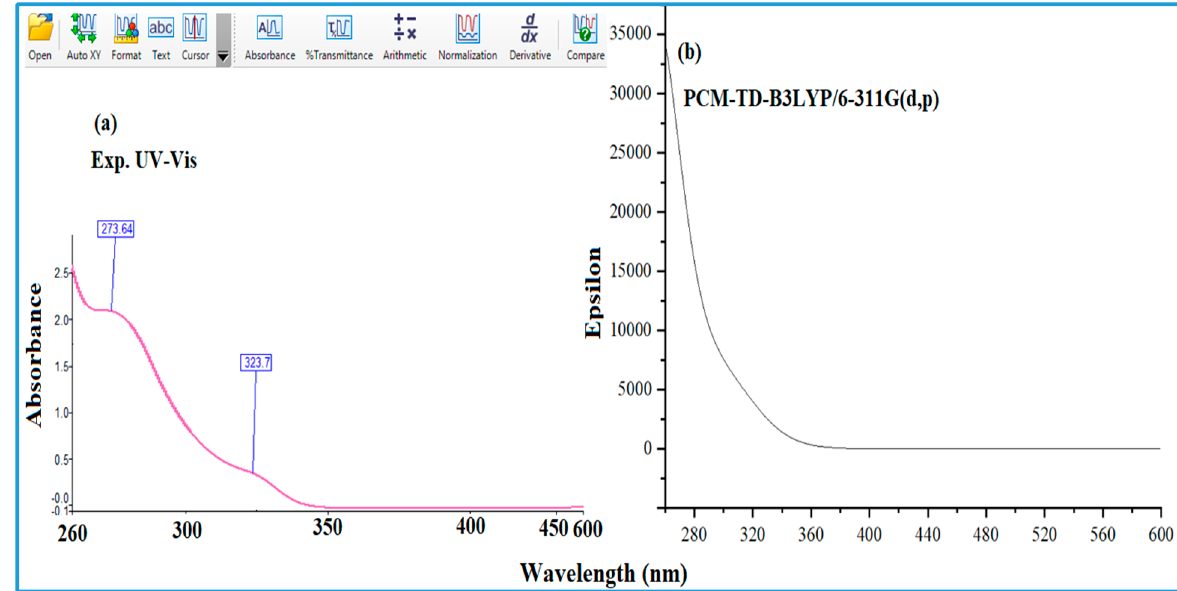
Figure 6. Energy levels, gaps and localization distribution of HOMO and LUMO (frontier molecular orbitals) of the ( a ) and ( b ) for compounds 1 and 2 , (energies are given in eV).